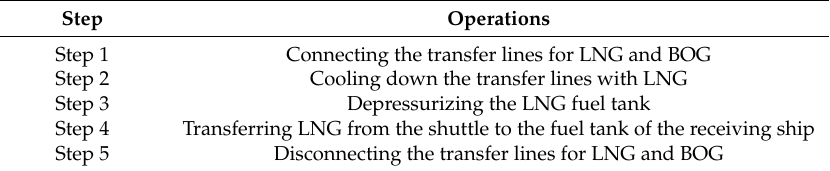
Table 1. Procedure of liquefied natural gas (LNG) ship-to-ship bunkering